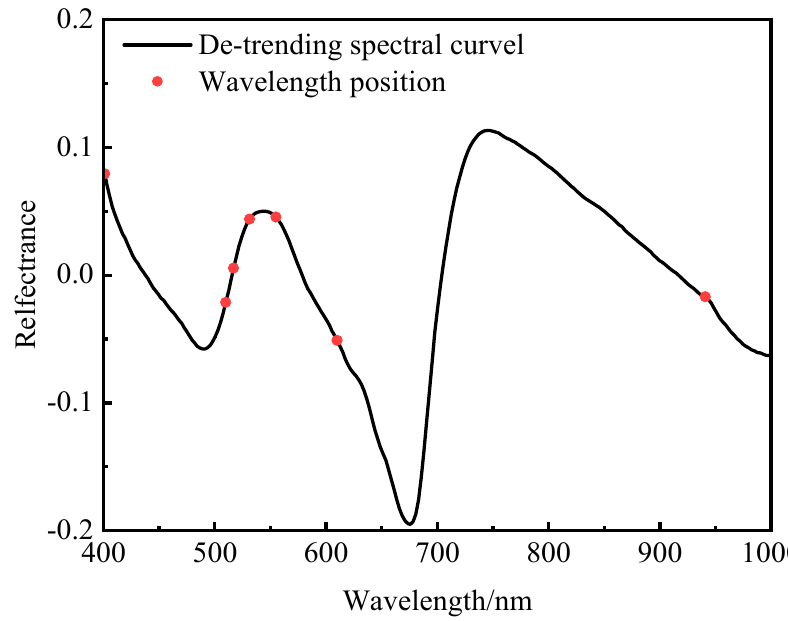
Figure 5. Characteristic wavelengths of the de-trending spectral curve selected using the SPA.